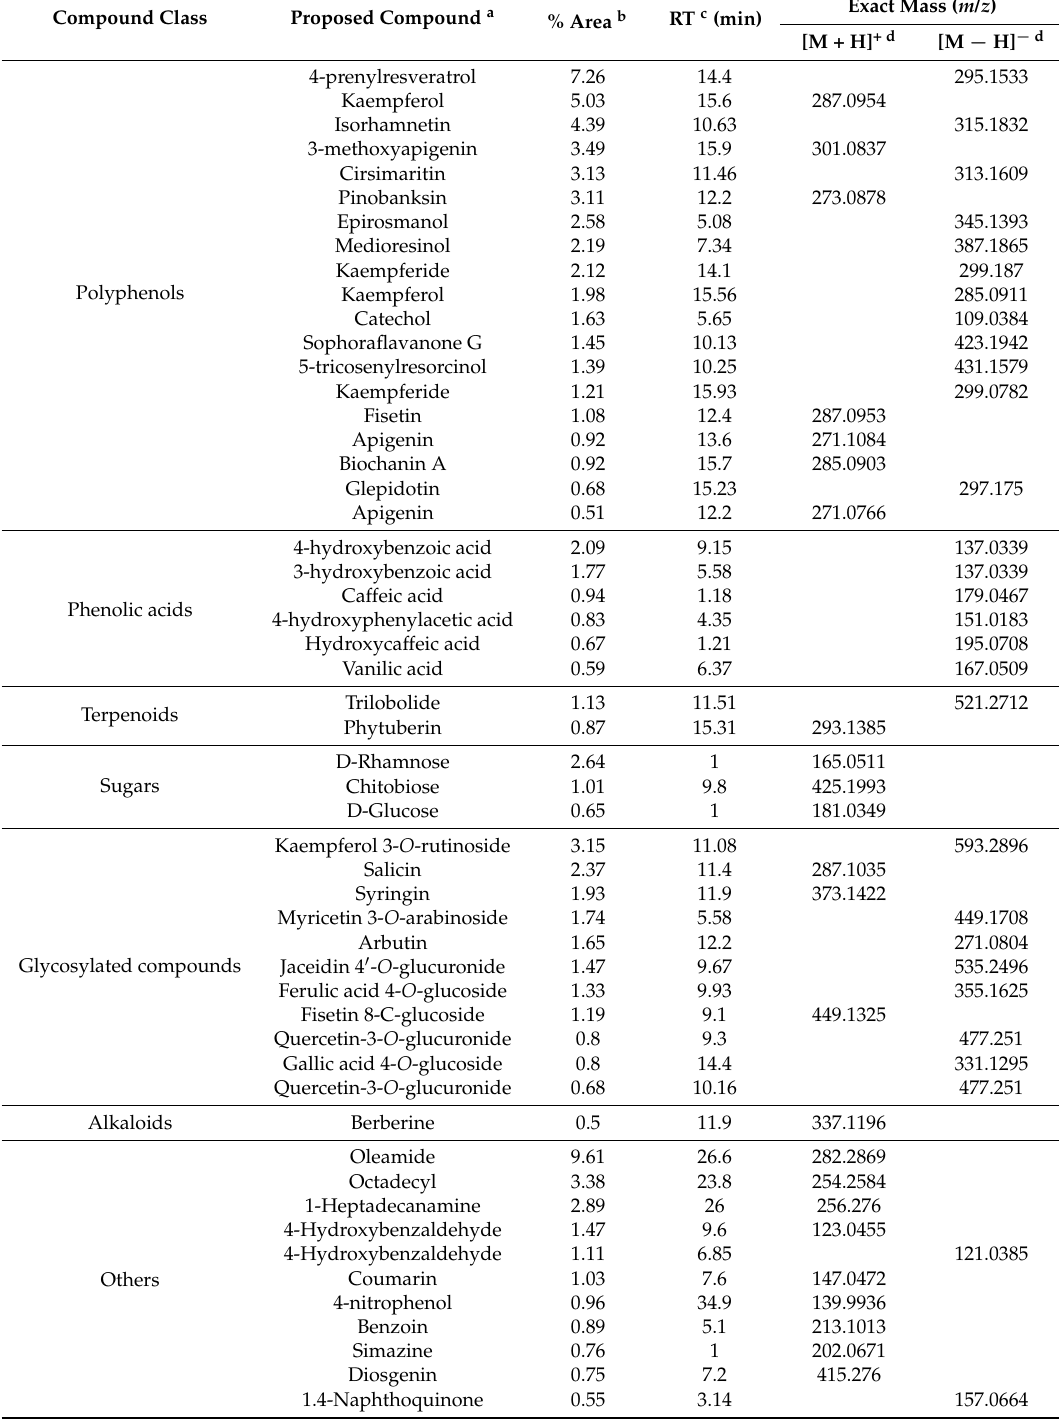
Table 3. Summary of the characterization of quaking aspen compounds of interest identified from water extracts following UPLC-QTOF-MS